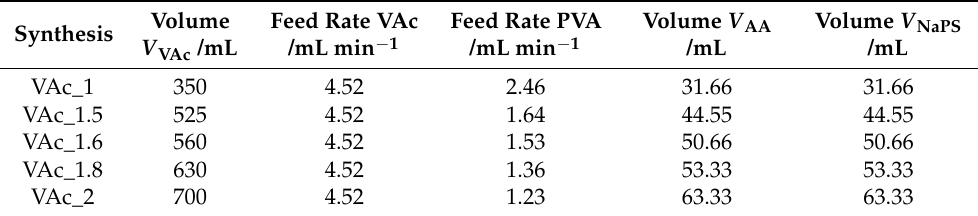
Table 1. Total dosed volumes and feed rates of monomer, 16.7% ( w / w ) PVA-water solution and initiators listed for each